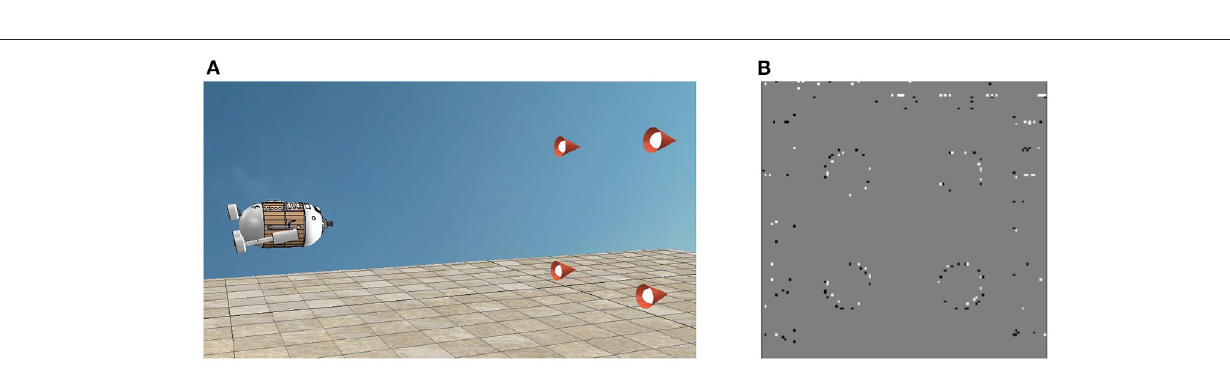
Frontiers in Neurorobotics |